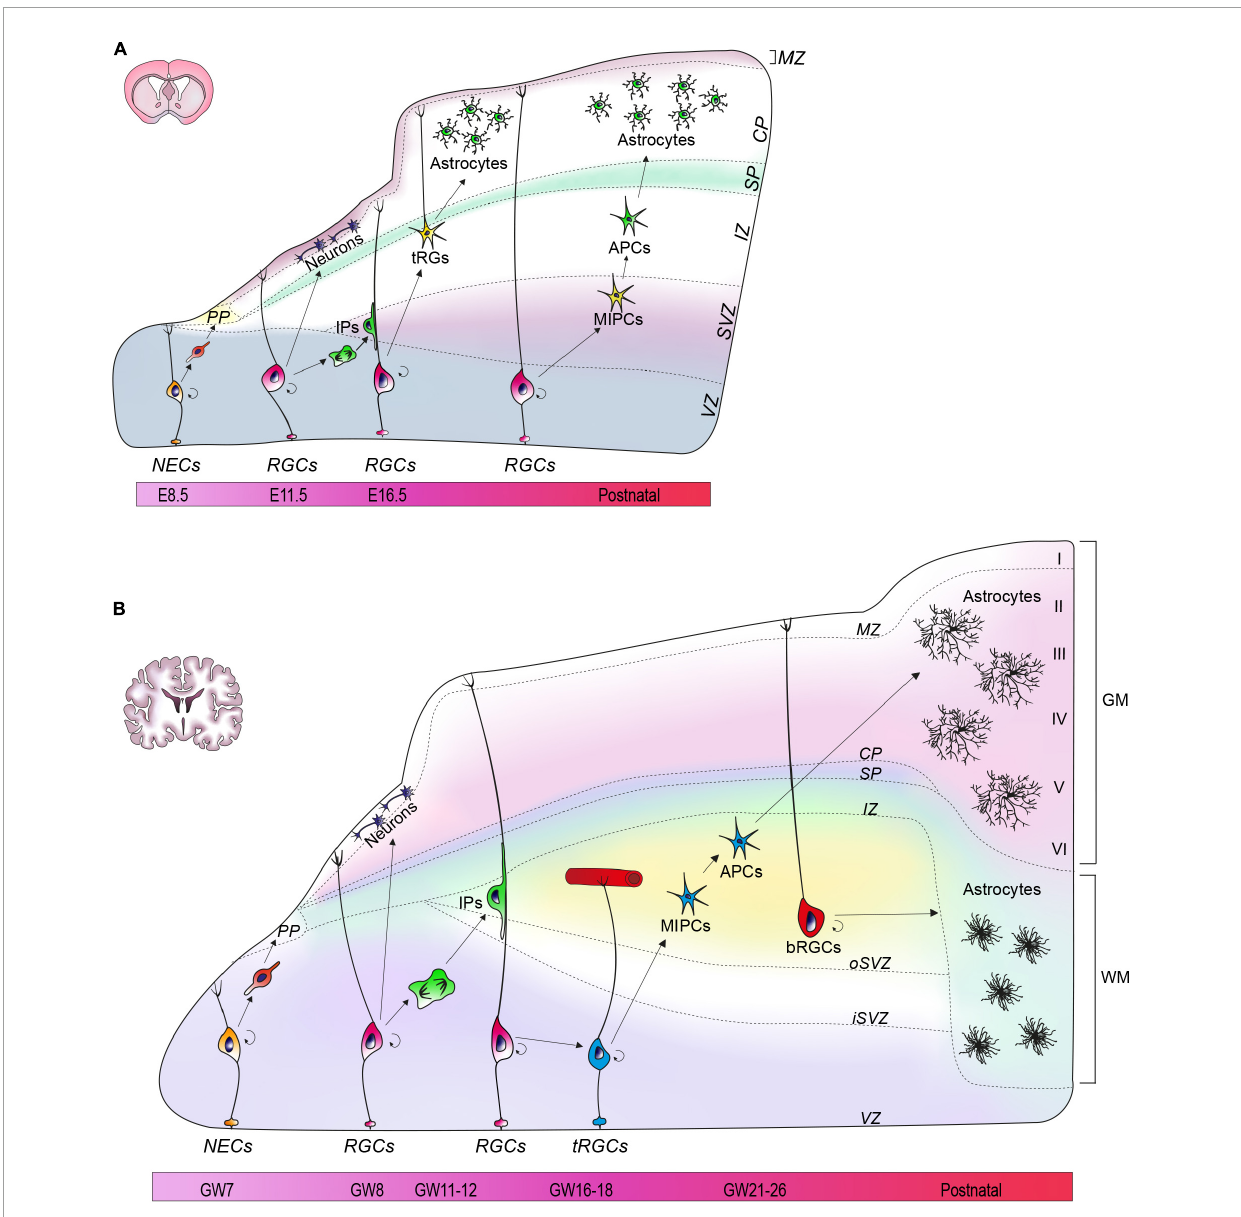
FIGURE1 Astrogenesis in mouse and human cortex. (A) At E8.5, neuroepithelial cells (NECs) are located in the ventricular zone (VZ). Around E10.5, the preplate (PP) appears and later divides into a marginal zone (MZ), a subplate (SP), and cortical plate (CP). Radial glial cells (RGCs) begin to generate astrocytes at E18.5. During the first wave of astrogenesis, RGCs give rise to transforming RGCs (tRG) that reside in the intermediate zone (IZ). In the second wave, intermediate progenitors (MIPCs) residing in the subventricular zone (SVZ) generate astrocytic progenitors (APCs). (B) At GW7, a single layer of NECs characterizes the developing human neural tube. Around GW7-8 the PP appears, and then divides into MZ, CP and SP. Astrogenesis begins around GW21-26 from two different sources: truncated RGCs (tRGCs) and basal RGCs (bRGCs). The tRGCs maintain the ventricular process and contact vasculature in the oSVZ, while detaching from the pial surface. The tRGCs generate multipotent intermediate progenitors (MIPCs) that localize between the oSVZ and the inner SVZ (iSVZ). From the MIPCs, APCs arise and eventually differentiate into gray matter (GM) astrocytes. bRGCs detach their basal process from the VZ and reside in the outer SVZ (oSVZ), where they generate white matter (WM)